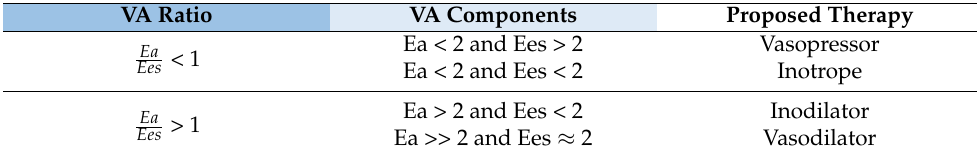
Table A2. Decision tree algorithm to help integrate VA coupling into routine hemodynamic therapy according to Guarracino et al.